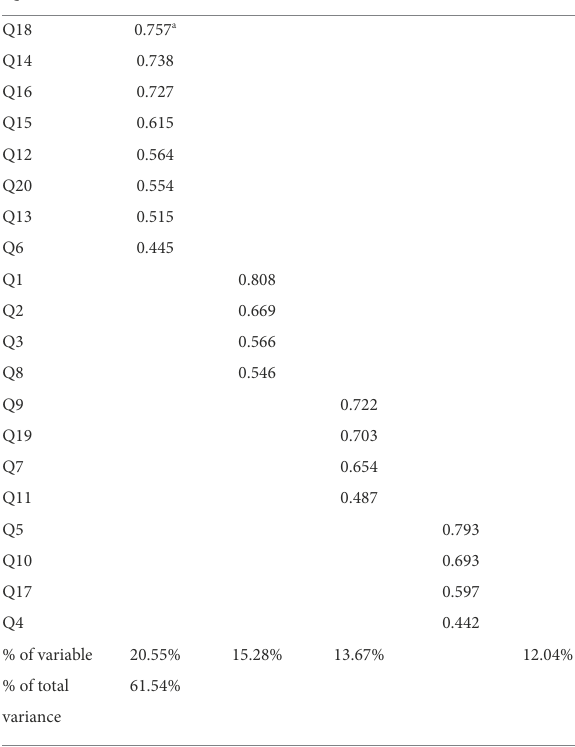
TABLE 1 Factor analysis of the FLCAS in this